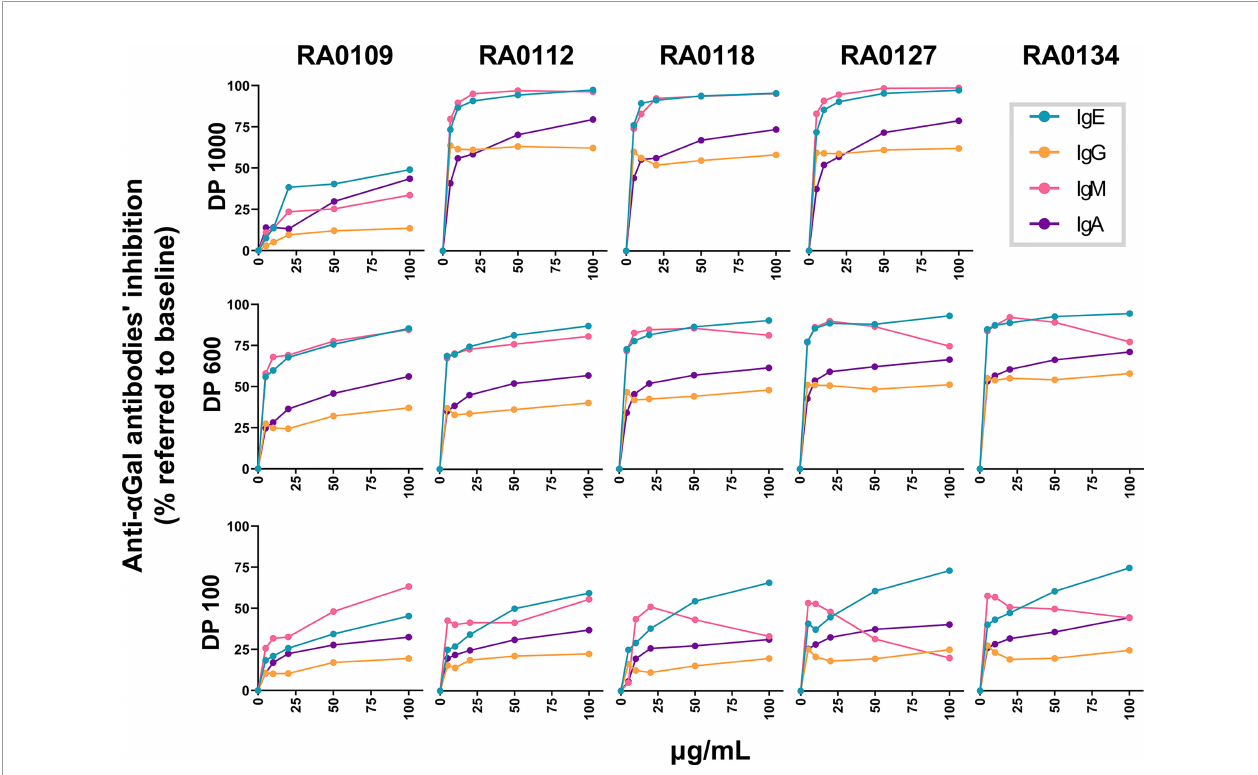
FIGURE 8 | Differential antibody inhibitory capacity of a Gal glycoconjugates with different DP and a Gal loads in serum from a Gal-sensitized patients. Serum samples (n=13) were incubated with the glycopolymers at growing concentrations (5-10-20-50-100 µg/mL). PBS-treated serum was similarly incubated as a baseline condition. After incubation, samples were conveniently diluted to determine by ELISA the unbound fraction of the different anti- a Gal isotypes (1:100 for IgM and IgG, 1:25 for IgA, and 1:10 for IgE). The inhibition rate for each glycopolymer (expressed as a percentage of anti- a Gal inhibition) was calculated according to the quantity of anti- a Gal antibodies determined in baseline (PBS) and treated (glycopolymer) conditions for each serum. IgE green line, IgG orange line, IgM pink line, and IgA purple